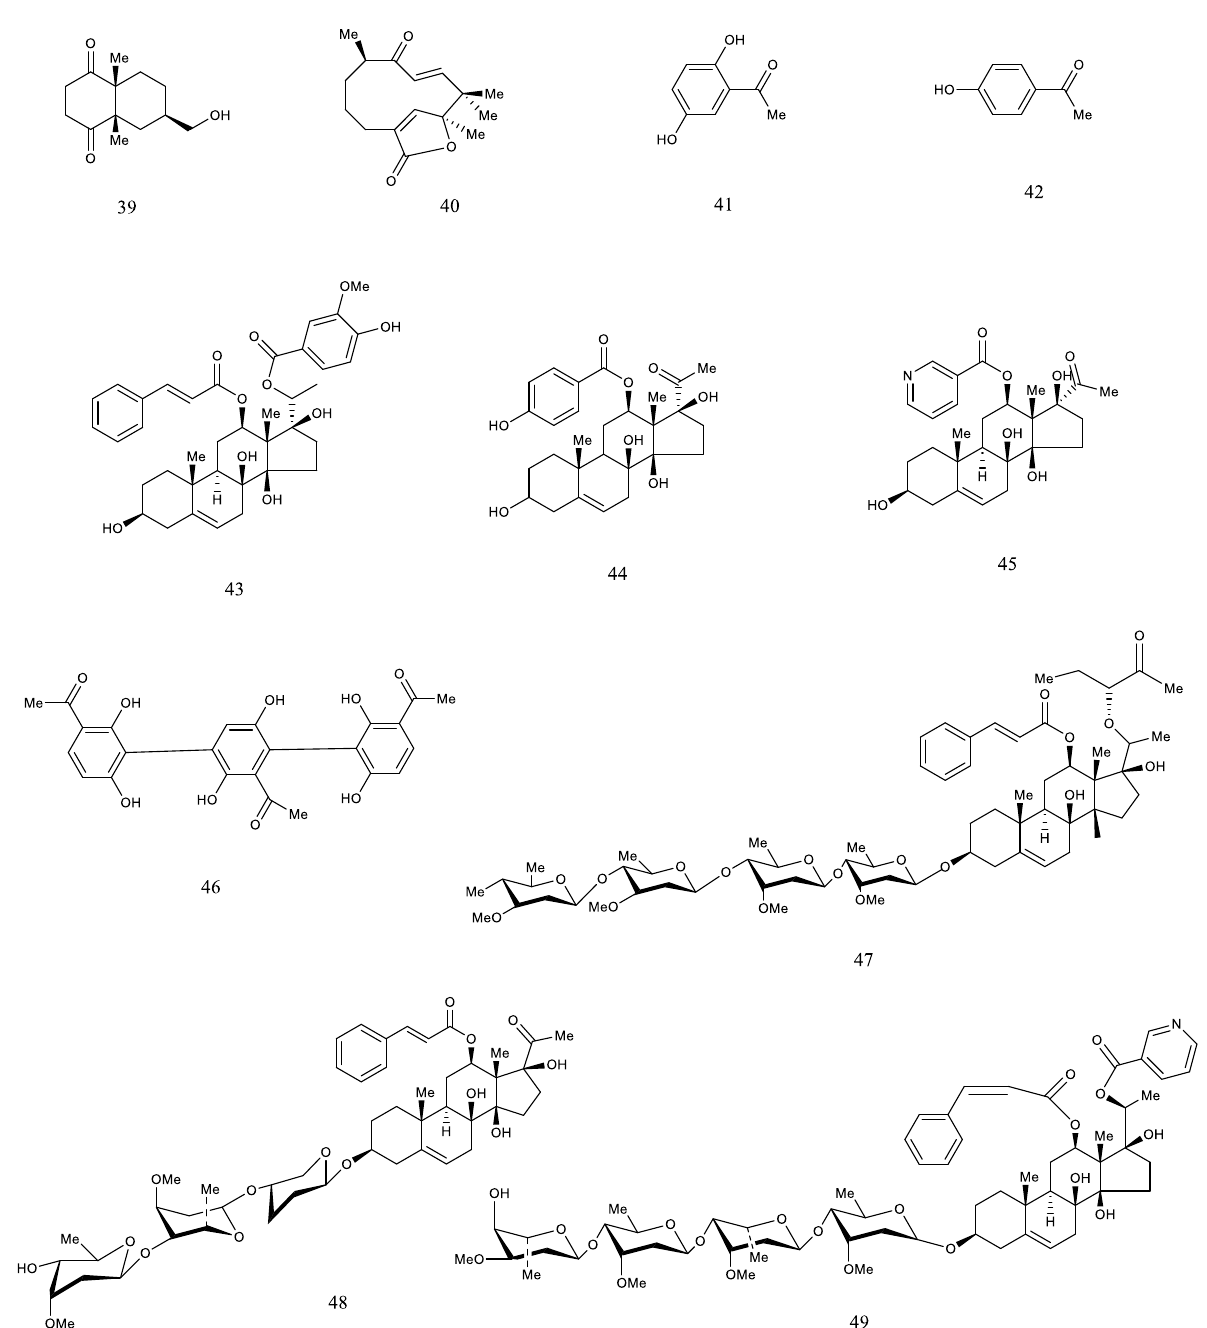
Figure 6. Chemical structures of bioactive compounds isolated from CA , CB and CW . Table 6. Pharmacological effects of bioactive compounds and extracts isolated from CA , CB and CW .